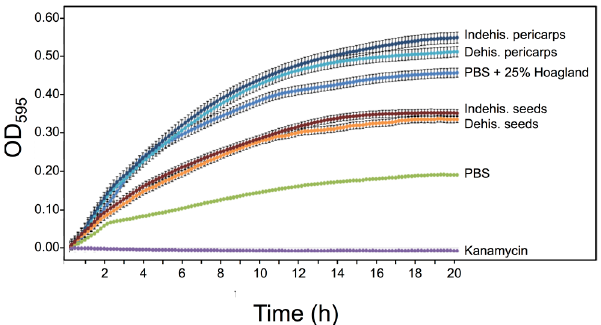
Figure 7. Pericarps of S. alba dehiscent and indehiscent fruit parts release substances that promote bacterial growth. Escherichia coli was grown in a flat-bottom 96-well microtiter plate in the presence of PBS, PBS + 25% Hoagland solution, kanamycin (50 µ g/mL), or in the presence of substances released from dehiscent and indehiscent seeds or pericarps. Bacterial growth was monitored by measuring the OD 595 of the culture at 30 min. intervals in the course of 20 h. Each treatment was performed in triplicates and error bars represent the standard deviation.